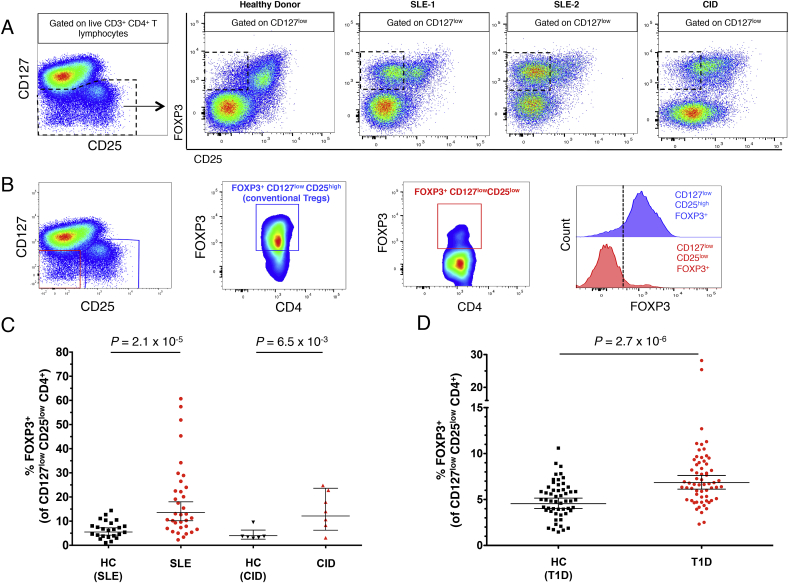
Frequency of CD25lowFOXP3+cells is increased in patients with autoimmune disease. (A) Patterns of CD25 and FOXP3 expression among CD127low CD4+ T cells from healthy donors and patients with autoimmune manifestations. (B) Gating strategy for the delineation of the T-cell subsets characterised in this study. Distribution of FOXP3+ cells among: (i) CD127lowCD25high conventional Tregs (depicted in blue); and (ii) CD127lowCD25low T cells (depicted in red). The vertical dotted line represents the threshold for the gating of FOXP3+ cells (histograms). (C, D) Scatter plots depict the frequency (geometric mean ± 95% CI) of FOXP3+ cells among CD127lowCD25low T cells in SLE patients (N = 34 patients vs 24 healthy donors) and combined immunodeficiency patients with active autoimmunity (N = 7 patients vs 6 healthy donors) (C); or in a cohort of T1D patients (N = 62; depicted by red circles) and healthy donors (N = 54; depicted by black squares) (D). P values were calculated using two-tailed unpaired t-tests. P values < 0.0167 were considered significant (Bonferronni correction for the comparison in three different diseases). The initial CD4+ T cell gate (CD4 versus dead cell exclusion dye) was derived from a lymphocyte gate (defined on forward and side scatter) followed by single-cell discrimination. HC, healthy controls; T1D, type 1 diabetes patients; SLE, systemic lupus erythematosus patients; CID, combined immunodeficiency patients.